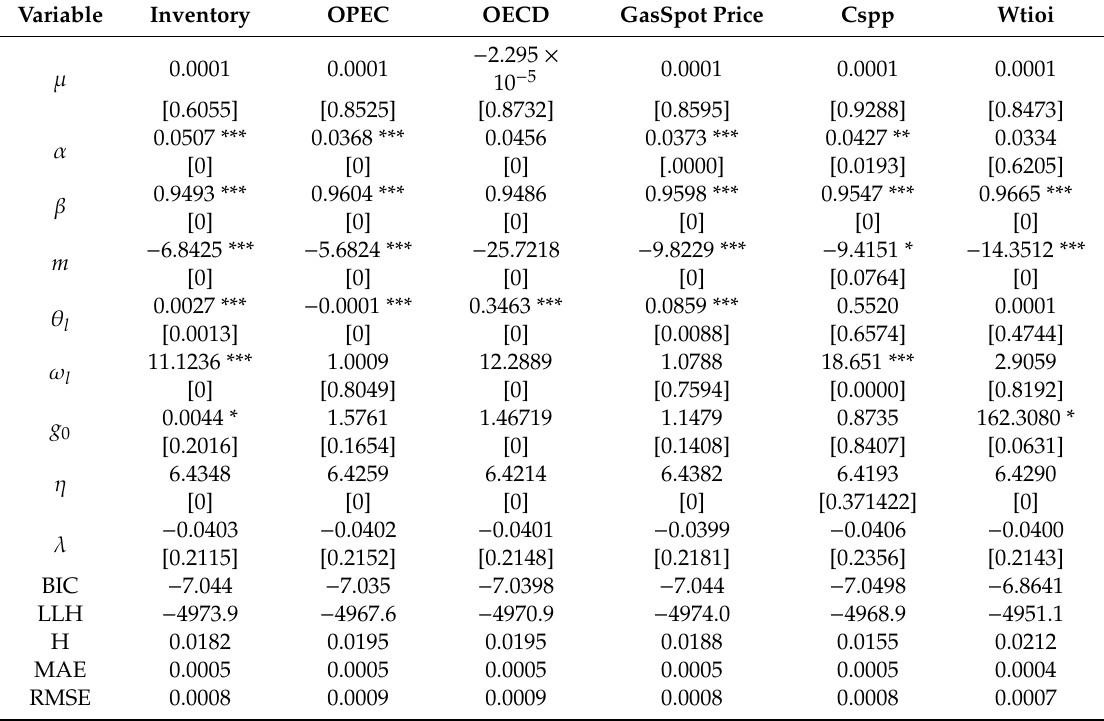
Table 3. Estimation results of low-frequency and single-factor level e ff ect.